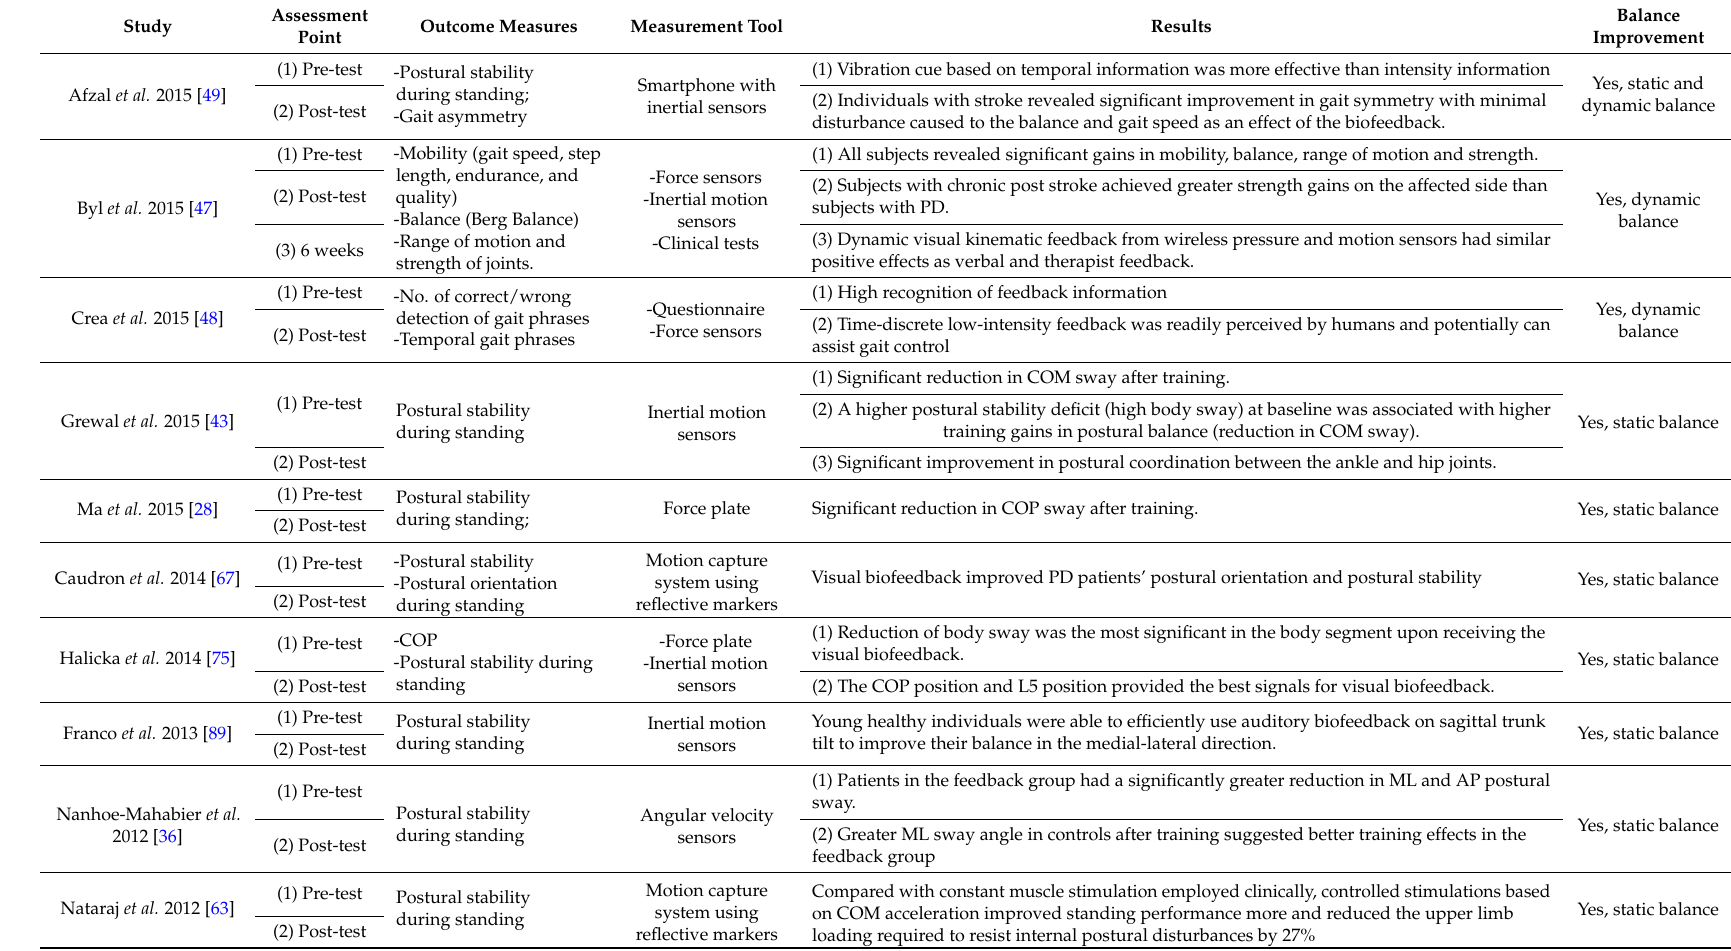
Table 9. Study outcome characteristics ( n =